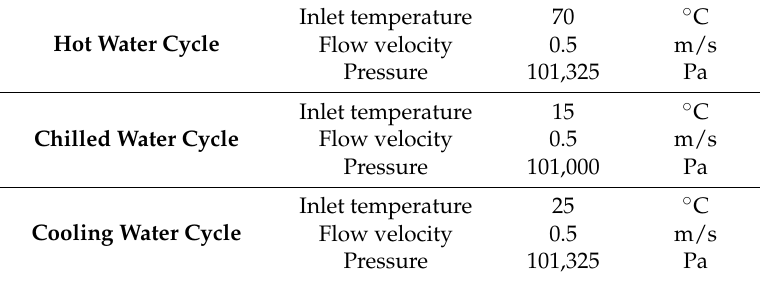
Table 4. Temperature data-2.